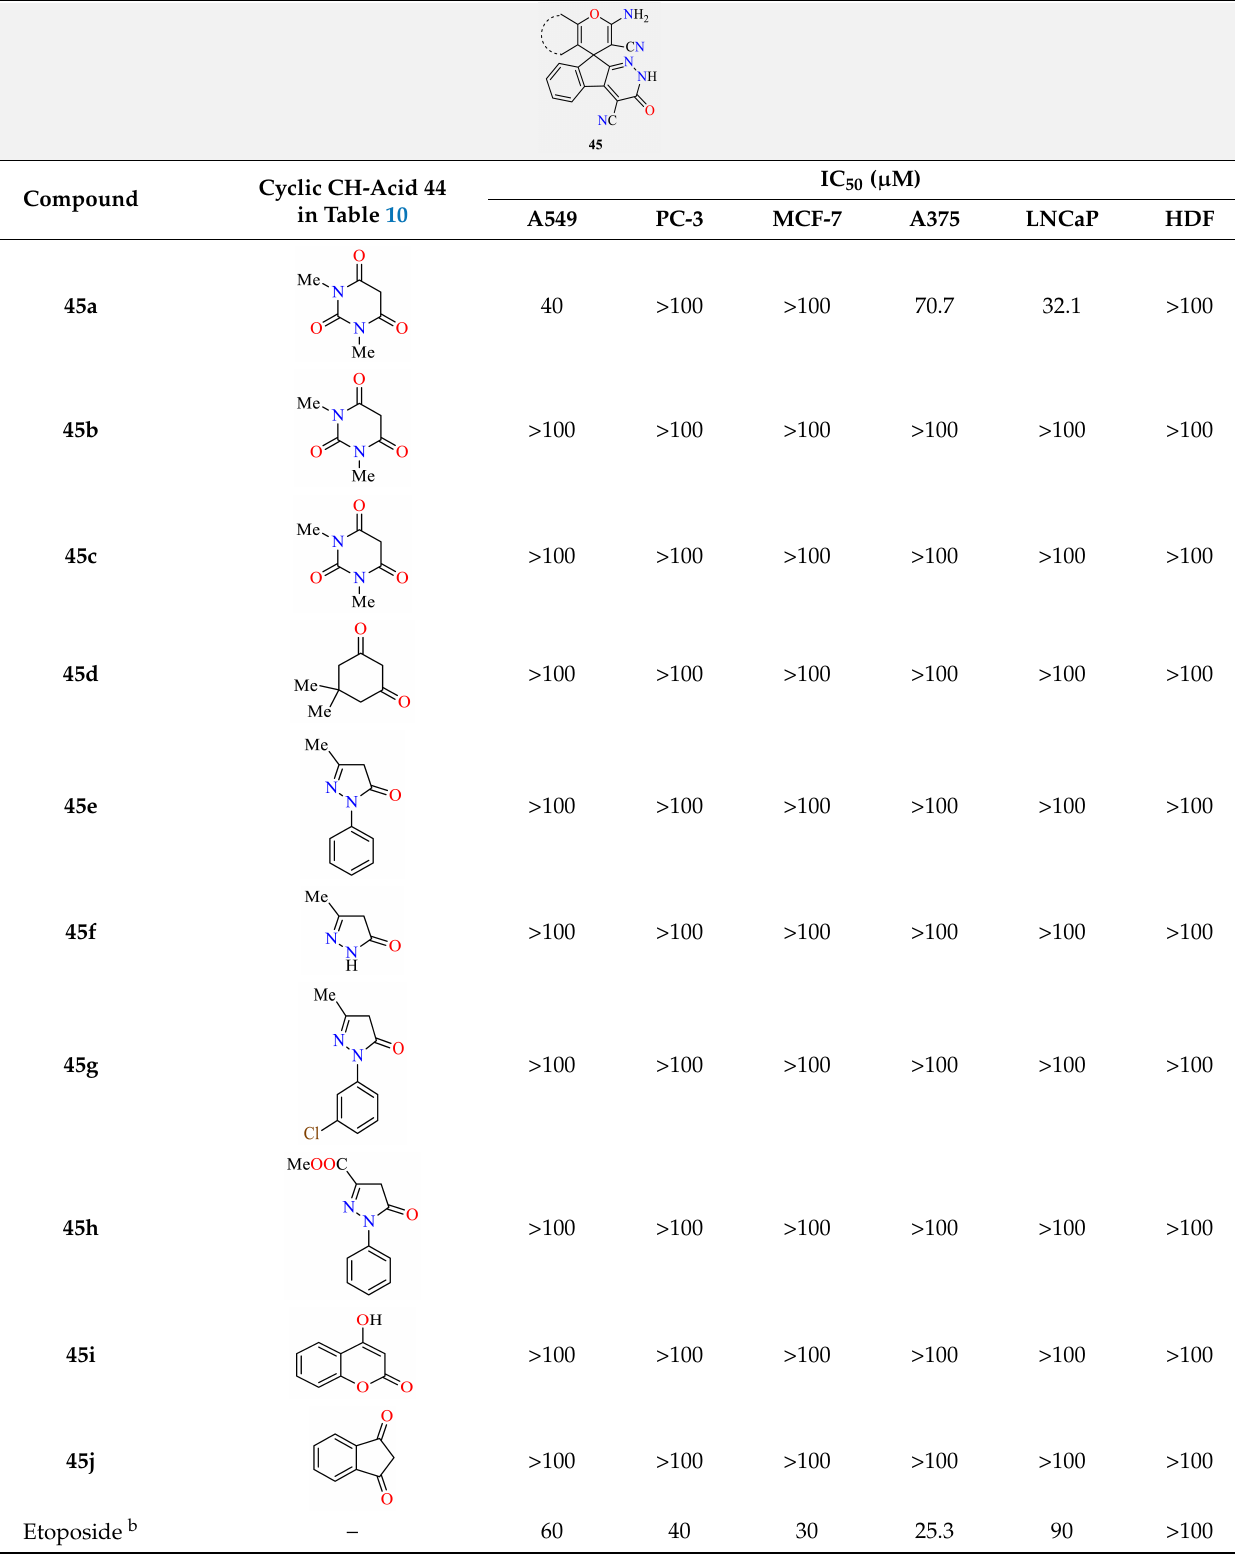
Table 32. Evaluation of spiroindenopyridazine-4 H -pyrans 45 against the cancer cell lines A549, PC-3, MCF-7, A375, LNCaP, and Normal cell HDF a